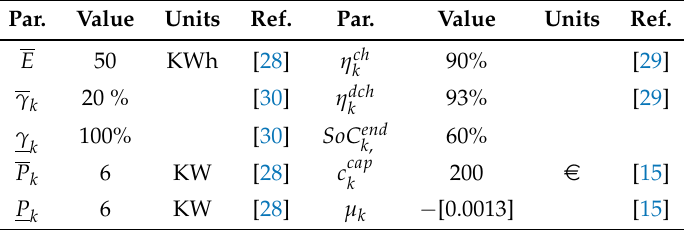
Table 1. General input parameters. Par.: parameter, Ref.: reference. Par.